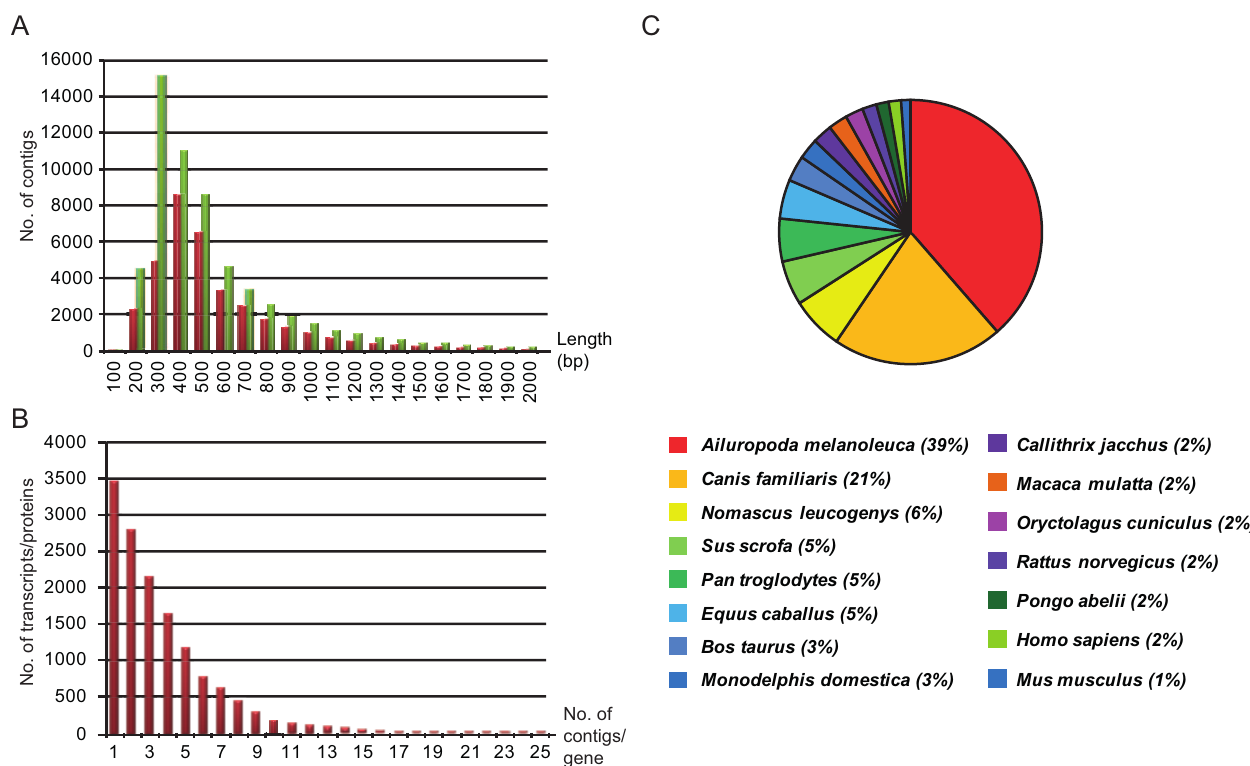
Figure 1. The histogram in panel A shows the distribution of contigs length of the sequence assemblies. The red bars indicate the length of the contigs from the assembly using the sequences from the cDNA library from infected tissues. The green bars show the contigs lengths for the combined assembly, built from these sequences as well as the ESTs previously reported [8]. The histogram in panel B illustrates the number genes that were represented by one or multiple non-overlapping of contigs in the combined assembly. Panel C shows the distribution of species extracted using the best hit (lowest blast E-value) from the Refseq Protein blast analysis of the combined assembly.